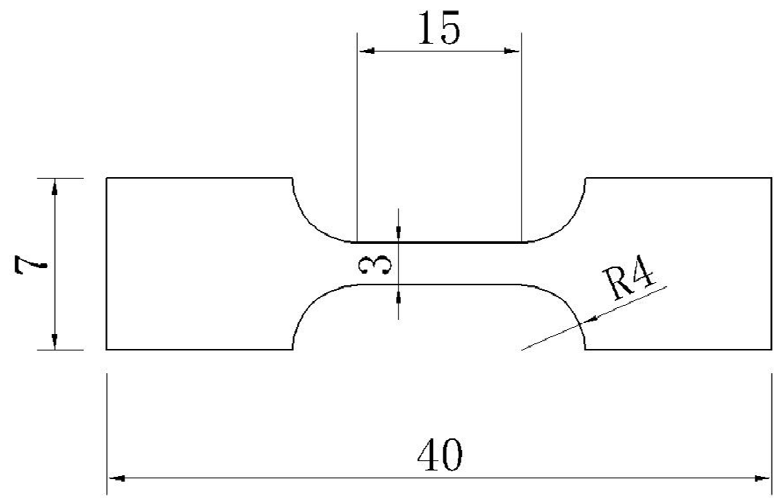
Figure 1. The size of the tensile test piece (unit: mm).